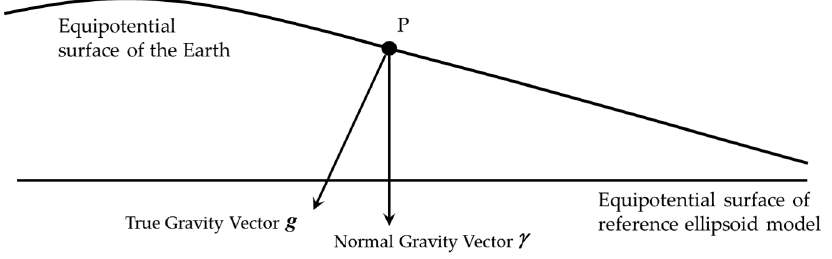
Figure 1. The definition of gravity disturbance vector, gravity disturbance and deflection of vertical, and this figure is adapted from [11].